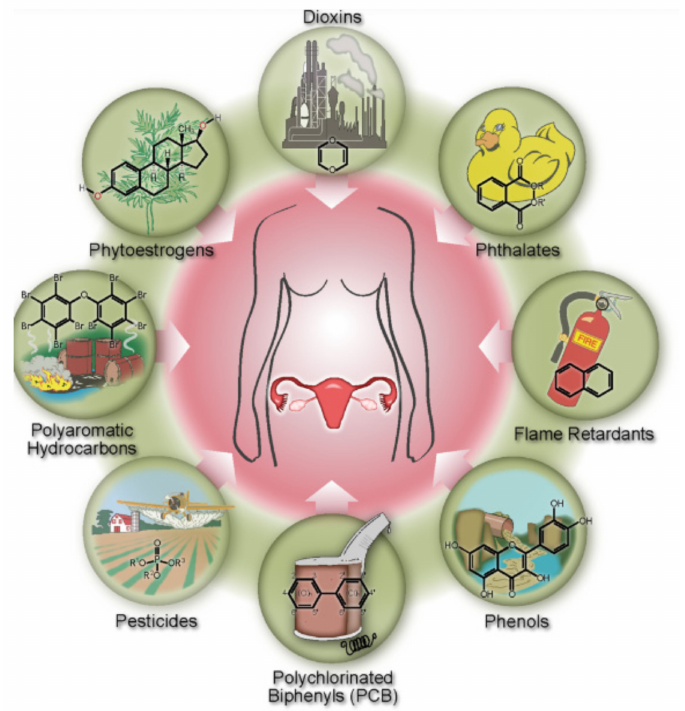
Figure 2. Vehiculation of endocrine disruptors in humans by MPs. Source: PLoS ONE